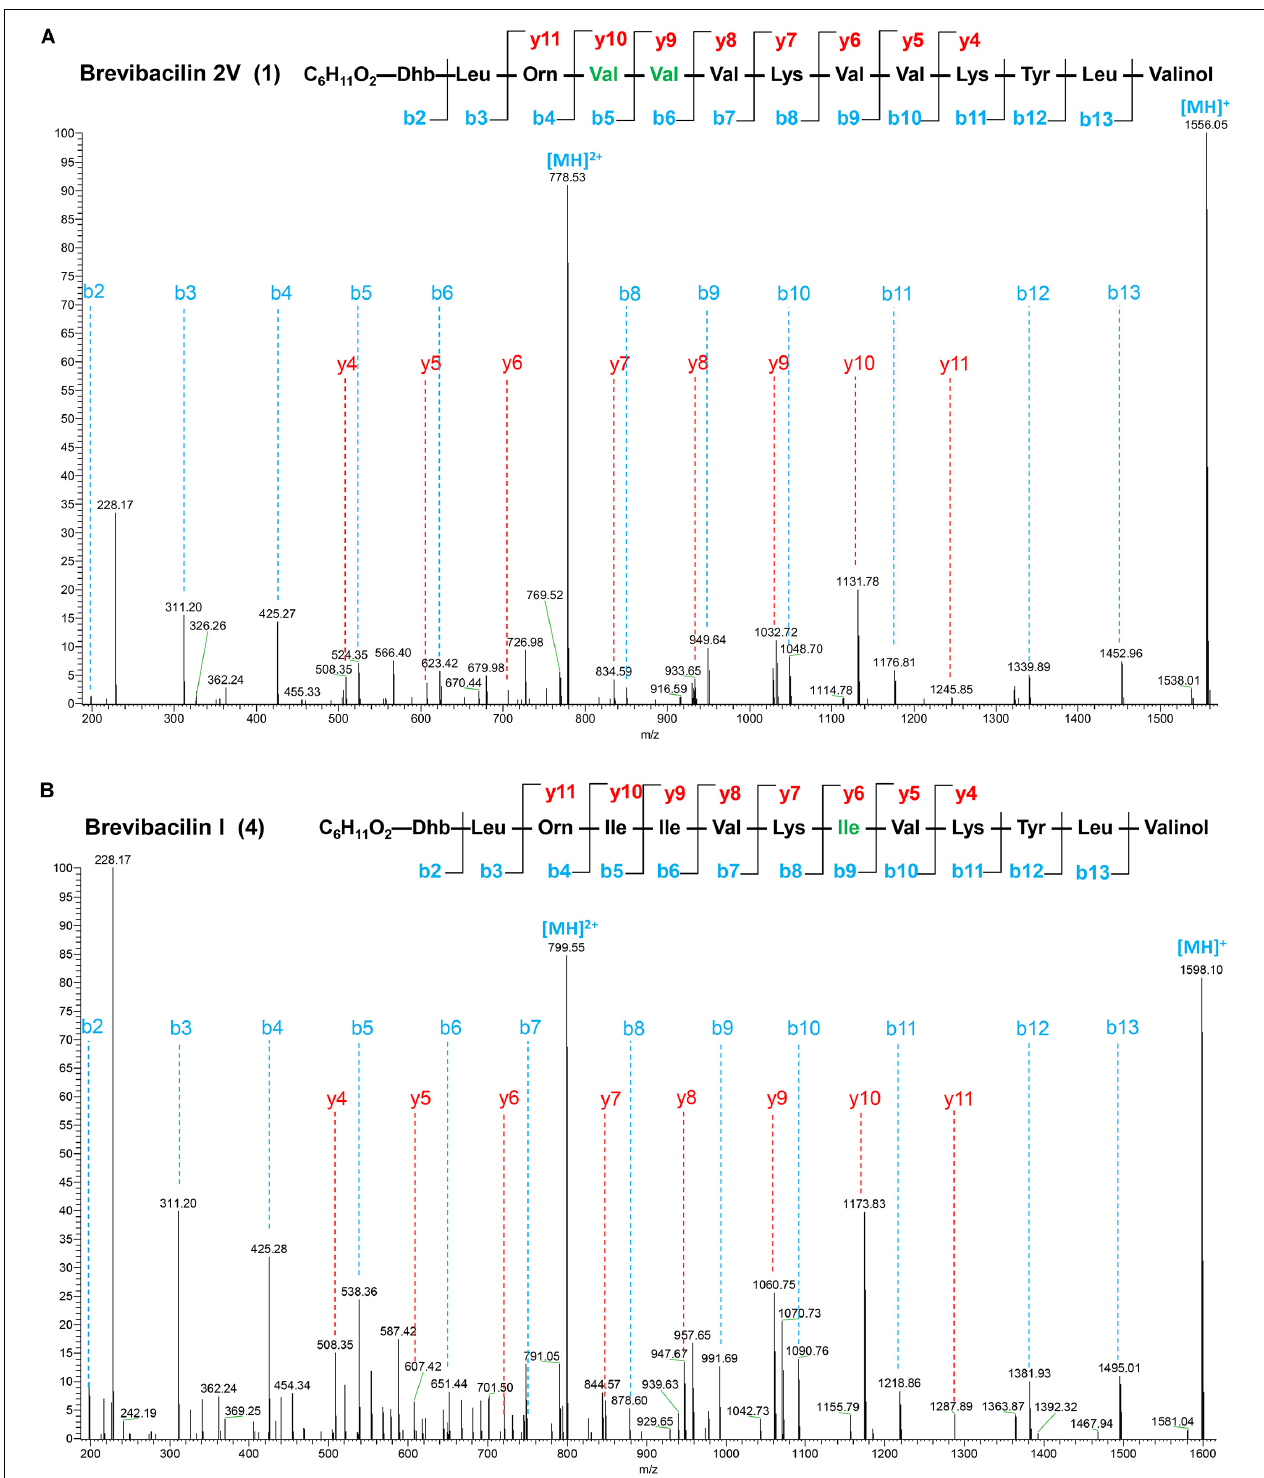
FIGURE 2 | Liquid chromatography-tandem mass spectrometry (LC–MS/MS) spectra and the proposed structures of brevibacillin 2V (A) and brevibacillin I (B) . Fragment ions are indicated. LC–MS/MS analysis was performed using a Q-Exactive mass spectrometer fitted with an Ultimate 3000 UPLC, an ACQUITY BEH C18 column (2.1 × 50 mm, 1.7 µ m particle size, 200 Å; Waters), a HESI ion source, and a Orbitrap detector. MS/MS was performed in a separate run in parallel reaction monitoring mode, selecting the doubly and triply charged ion of the peptides. The structures of brevibacillin 2V and brevibacillin I were elucidated by using known lipo-tridecapeptides as reference